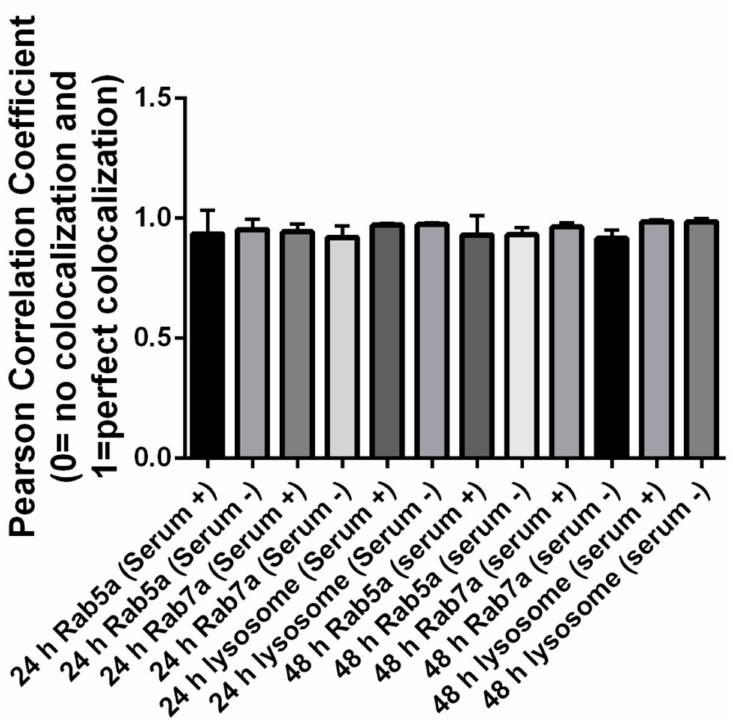
Figure 9. Colocalization assay depicting the level of colocalization between CdSe/ZnS QD and fluorescence organelle markers in ML-1 cell culture. Graph bars represent the results of colocalization analysis using the JACoP plugin from ImageJ using Pearson’s correlation coefficient. Mean Pearson coefficient and standard deviation values for levels of colocalization between QDs and fluorescent organelle markers are indicated in the